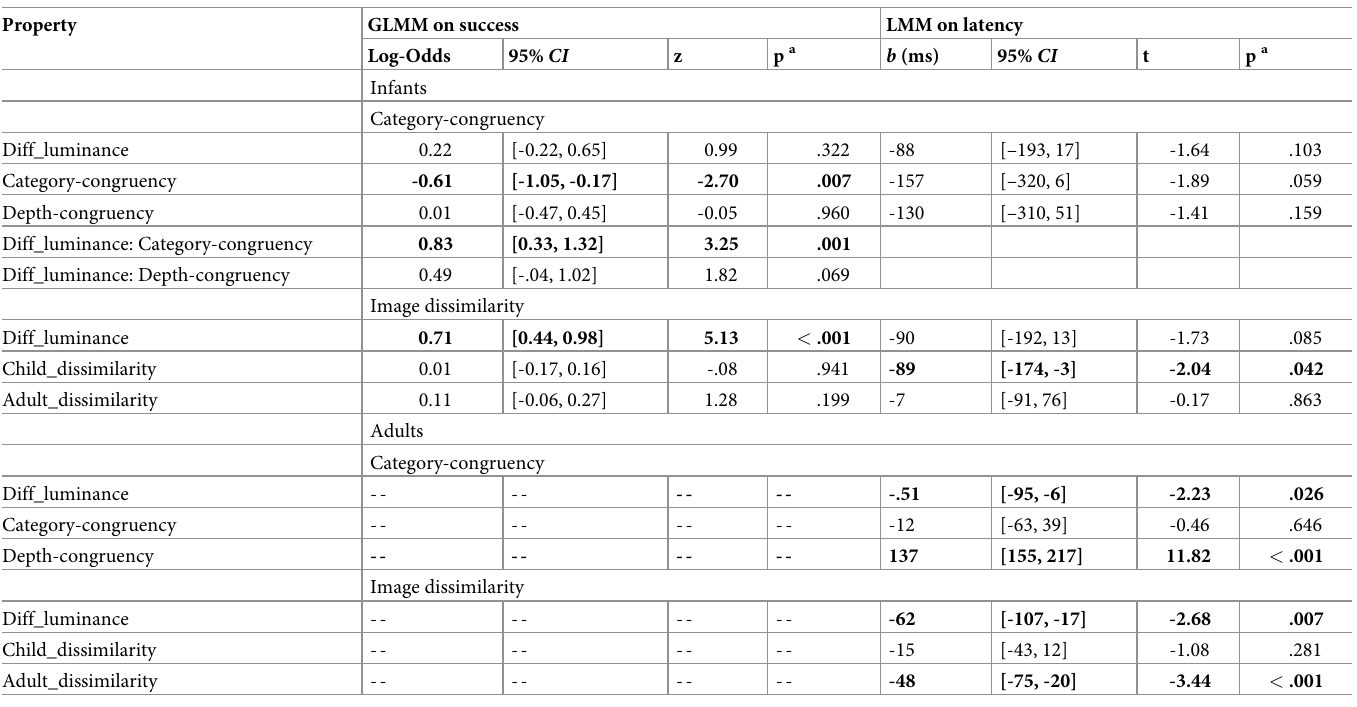
Table 3. Results for congruency and image